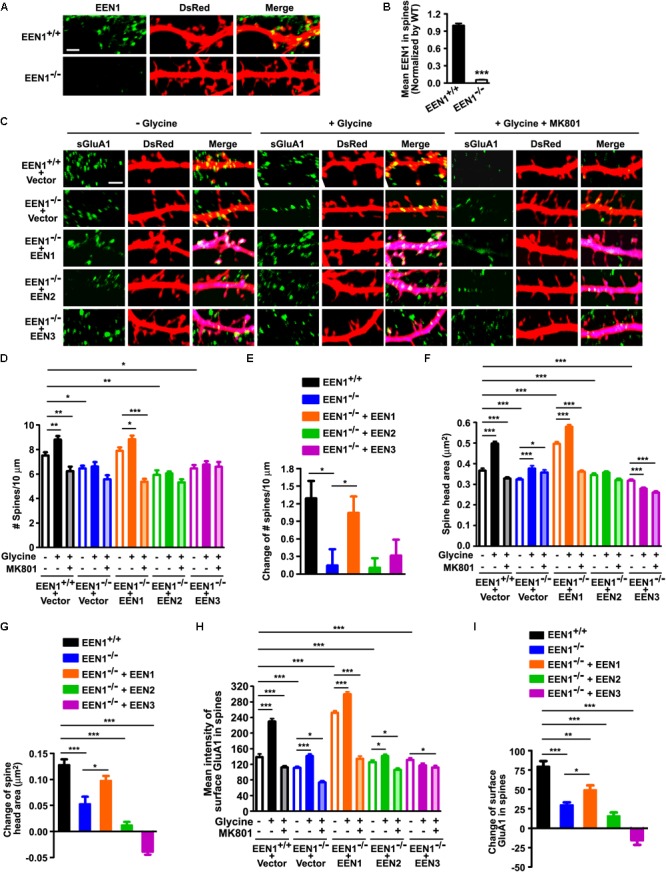
EEN1 is required for the structural and functional plasticity of dendritic spines. (A) Cultured EEN1+/+ and EEN1-/- hippocampal neurons were transfected with pLL3.7.1 on DIV12-13 to express DsRed as volume marker, fixed and immunostained for EEN1 and DsRed on DIV19. Shown are representative confocal images of dendrites. (B) Quantification of EEN1 fluorescent signals in spines in A, normalized to levels of EEN1+/+ neurons. Data represent mean ± SEM, n > 10 neurons, >600 spines per group, ∗∗∗p < 0.001. (C) Cultured EEN1+/+ and EEN1-/- neurons co-transfected with DsRed expression construct and Flag vector, and EEN1-/- neurons co-transfected with constructs expressing DsRed- and Flag-tagged EEN1, EEN2, or EEN3 on DIV12-13 were treated with glycine to induce chemLTP with or without MK801 pretreatment on DIV18, and immunostained for surface GluA1, Flag, and DsRed. Shown are representative confocal images of dendrites. (D) Quantification of spine density in C. (E) Changes of spine density in C. (F) Quantification of spine head area in C. (G) Changes of spine head area in C. (H) Quantification of surface GluA1 levels in spines in C. (I) Changes of surface GluA1 levels in spines in C. Data represent mean ± SEM in D–I, n > 15 neurons per group, >850 spines per group, ∗p < 0.05, ∗∗p < 0.01, ∗∗∗p < 0.001. Scale bars, 2 μm.